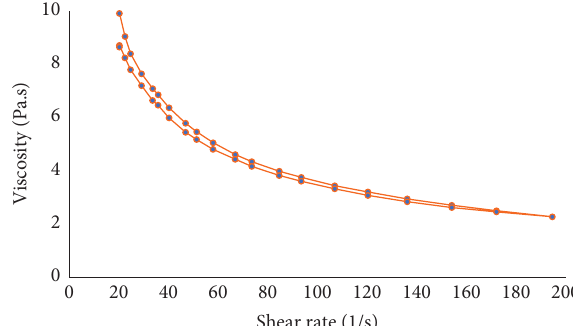
Figure 4: Viscosity versus shear rate profile of the fabricated LUL-NEG.